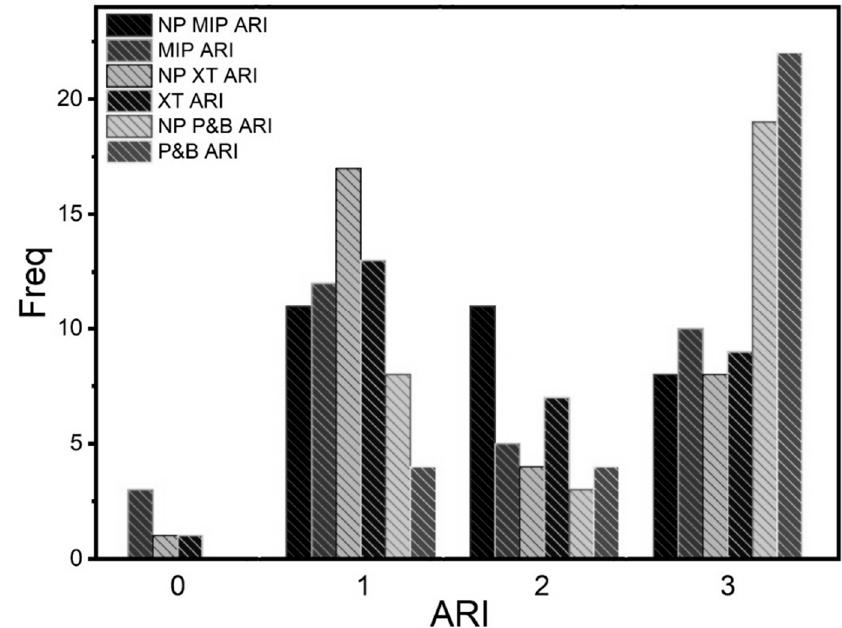
Figure 2. The mean SBS of the bracket to enamel in the six groups with a 95% confidence interval. The frequency of adhesive failure in the six groups showed that mixed failure was most prevalent among the six groups (Figure 3 and Table 2).